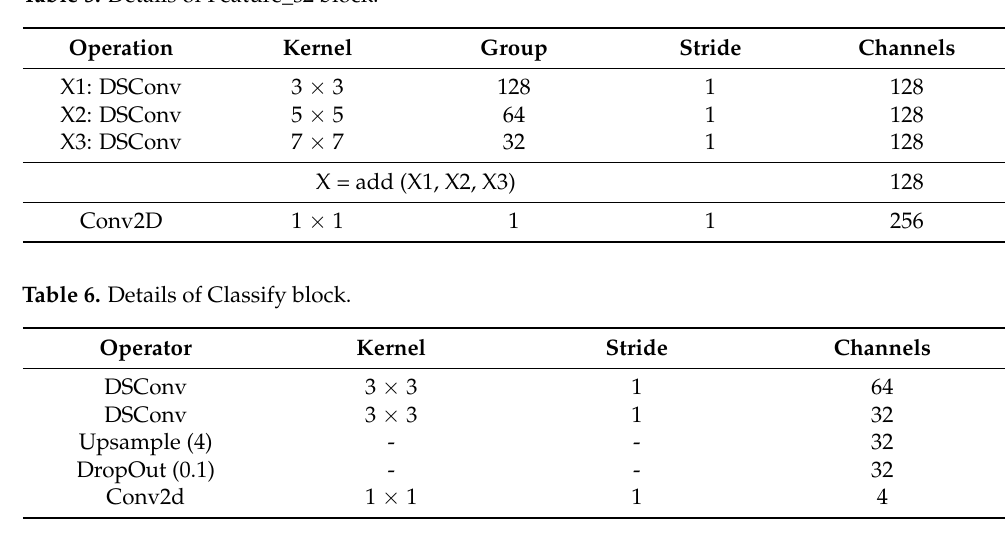
Table 5. Details of Feature_s2 block.